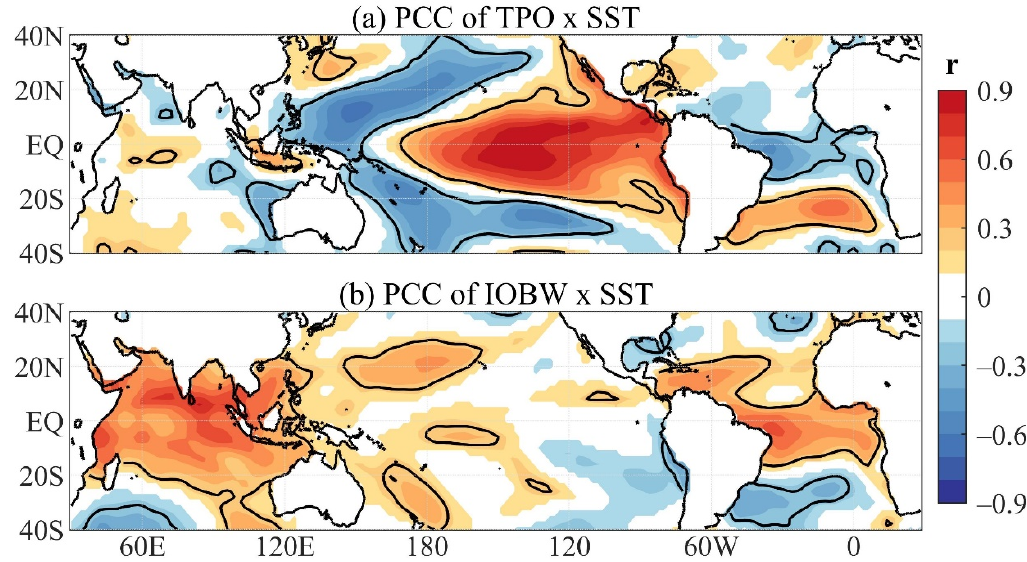
Figure 3. Partial correlations for SST during southern summer of the ( a ) TPO and SST; ( b ) IOBW and SST. Continuous line encompasses significant correlations at a 95% confidence level using the level using Student’s t ‐ test.